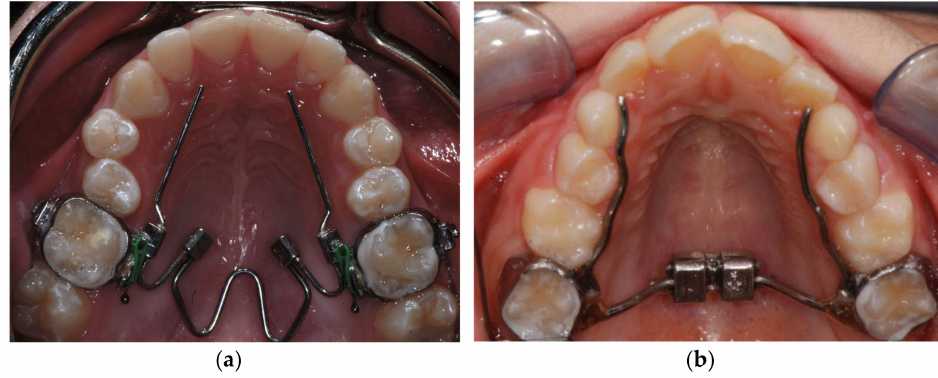
Figure 1. ( a ) Nitanium ® Palatal Expander™ (NPE-2); ( b ) Rapid Palatal Expander